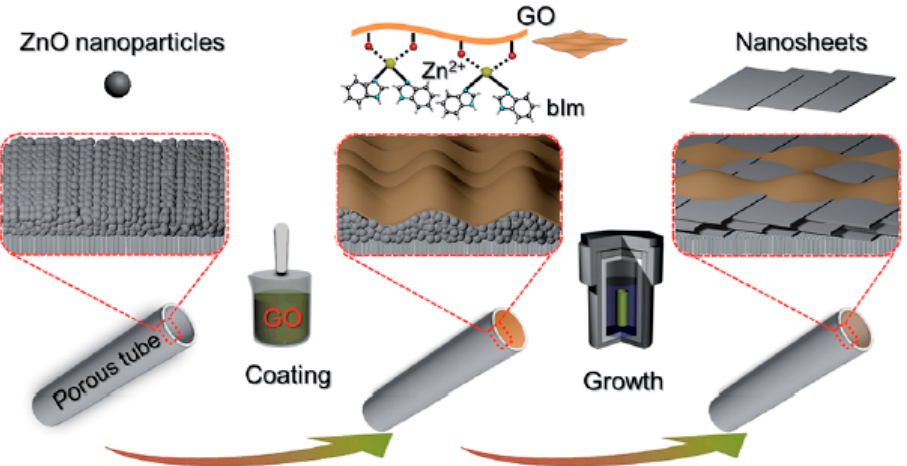
Figure 45. Scheme depicting the preparation procedure of highly oriented Zn 2 (bIm)4 nanosheet membranes by ZnO self-conversion growth in a GO confined space (adapted with permission from ref. [122]).